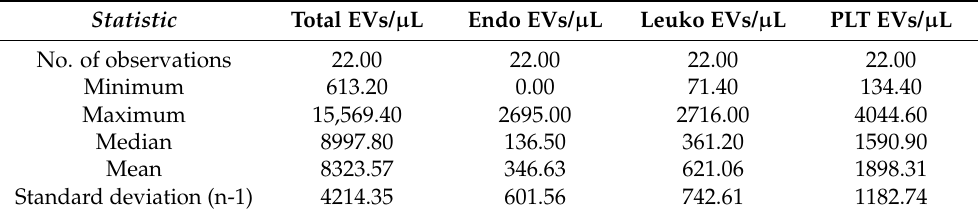
Table 1. Absolute numbers of EVs and EVs subtypes in healthy PB samples.